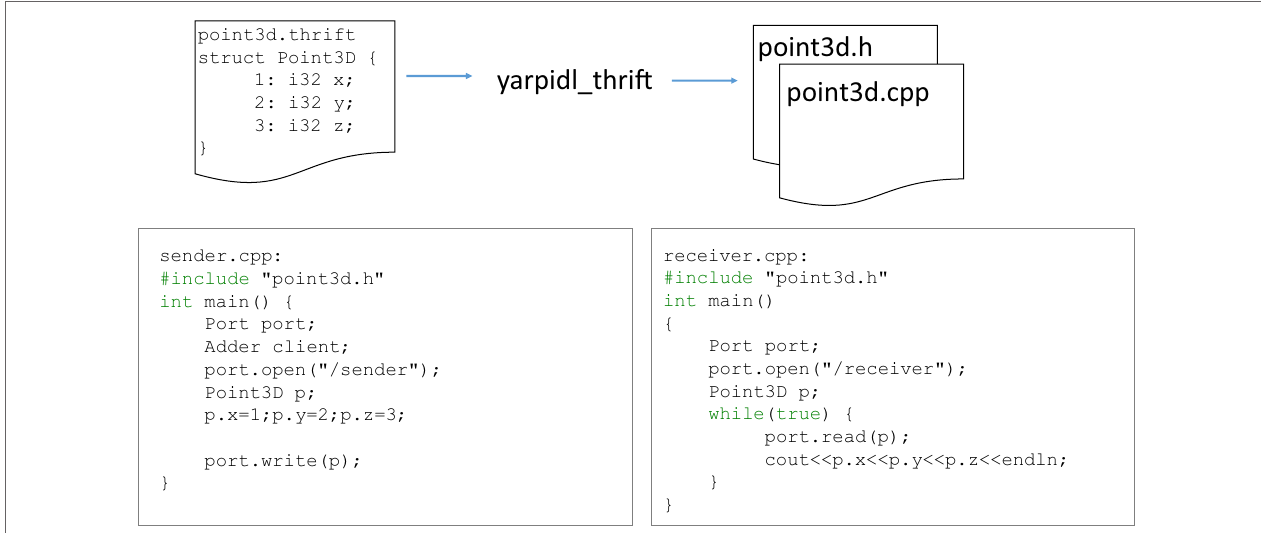
FigUre 2 | specification of a new type using Thrift . The yarpidl_thrift compiler generates the C ++ object that implements the type Point3D starting from its specification in the Thrift IDL. Bottom: this object contains serialization and deserialization functions and can be used directly for read/write operations in a YARP Port or BufferedPort (not